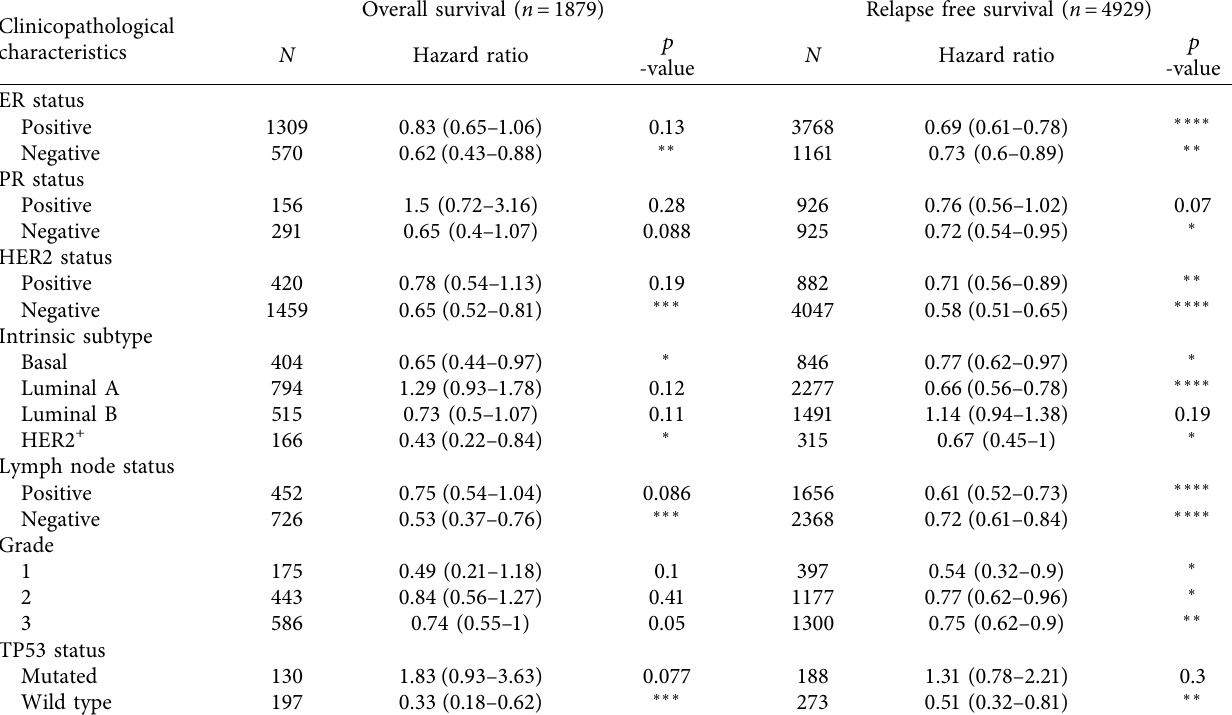
Table 2: Kaplan–Meier plotter to determine the efect of diferent clinicopathological factors on the expression of MYL5 gene and clinical prognosis in breast